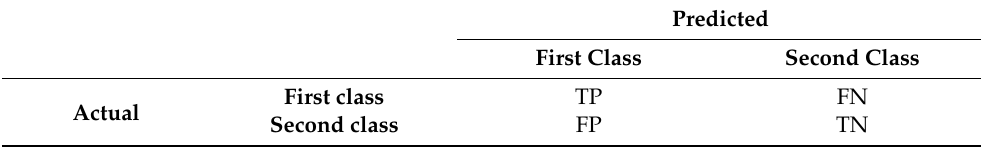
Table 3. Confusion matrix to evaluate the performance of the learning